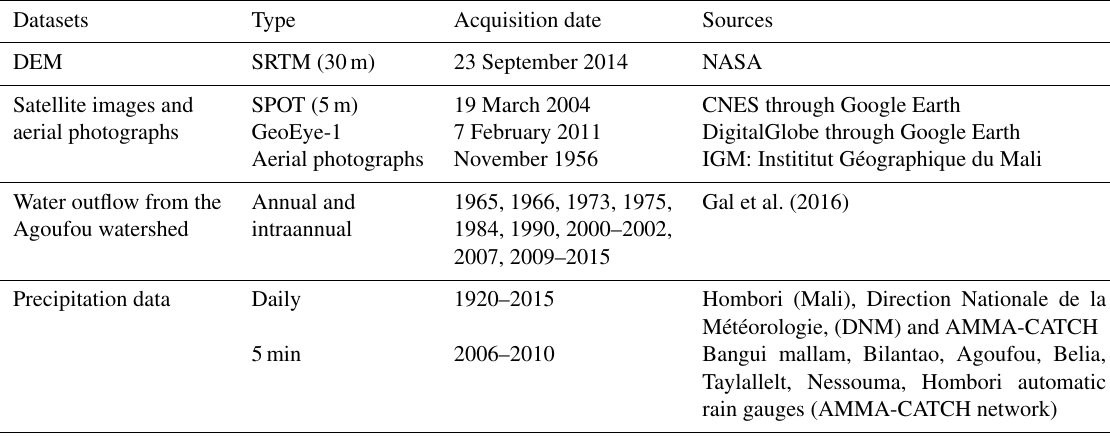
Table 1. Data available for the Agoufou watershed and used in input K2 model.